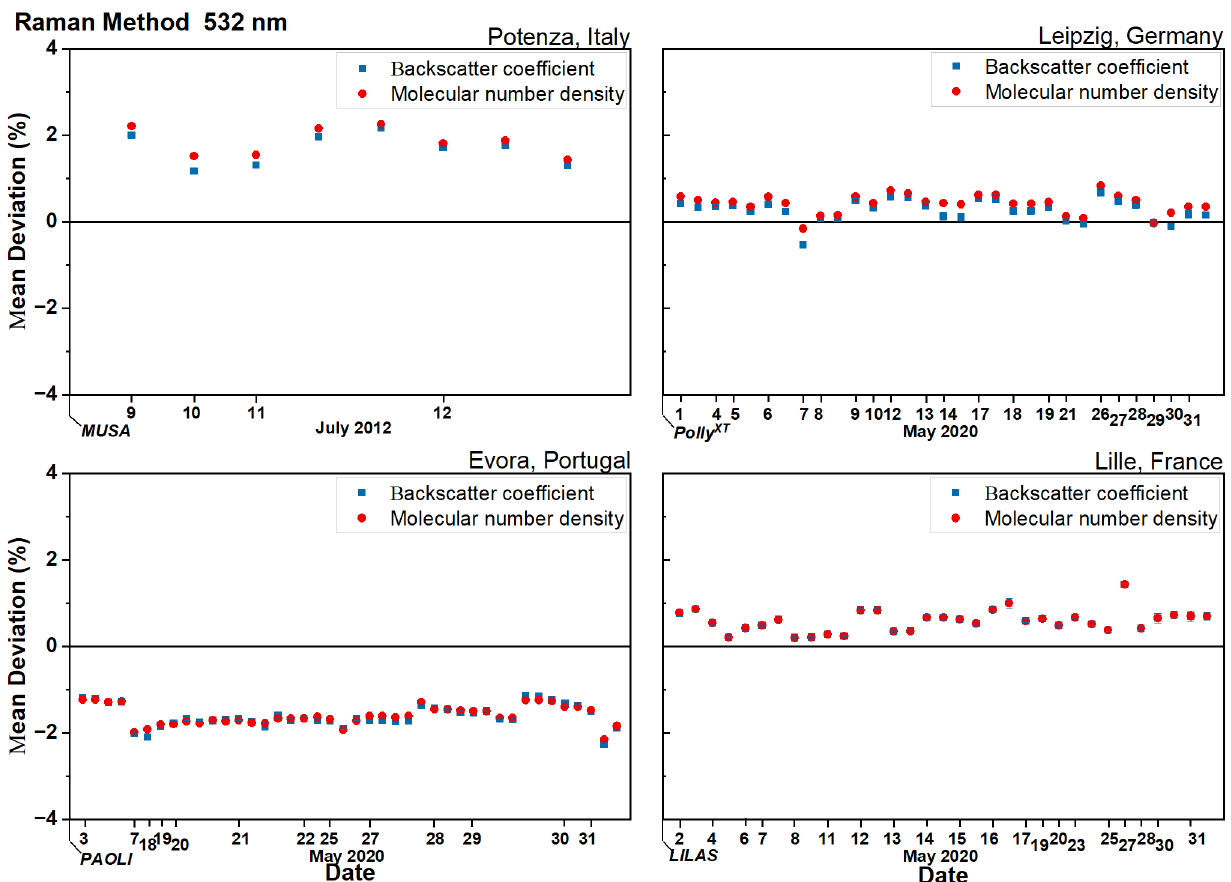
Figure 4. Same as Figure 3, but for 532